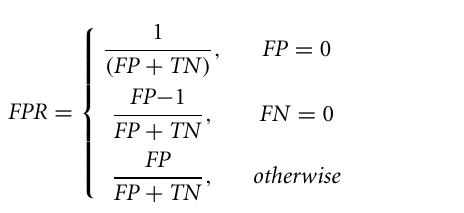
top to bottom, are HEOG, VEOG, and F7 (in white). The output of the adaptive filter is shown in red. Large amplitude artifact from blink activity (early in the time series) and saccadic activity (later in the time series) are absent in the noise-corrected time series. Y-axis units of all time series are given in